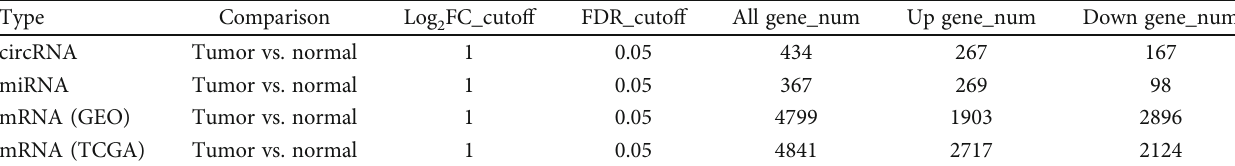
Table 1: Results of the di ff erential expression analysis among the GSE92675, GSE133624, and TCGA BLCA datasets. Type